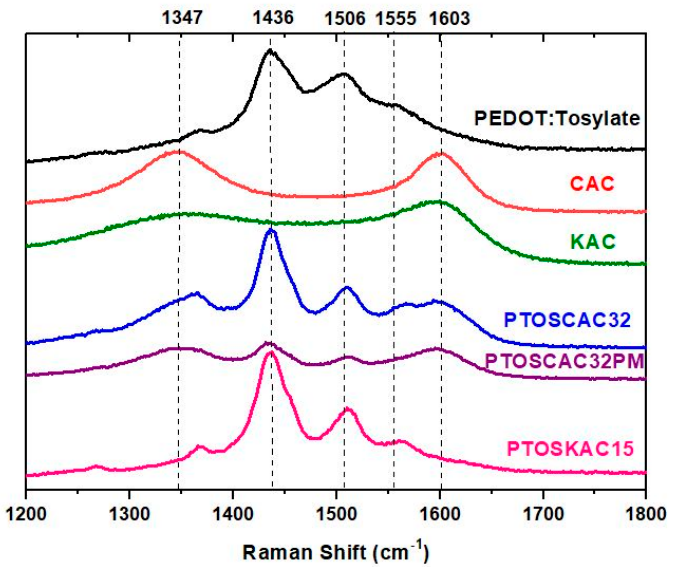
Figure 5. Raman spectra of PEDOT-activated carbon composite materials spectra of PEDOT:Tosylate (black), CAC (red), KAC (green), PTOSAC32 (blue), PTOSAC32PM (purple) and PTOSKAC15 (violet).